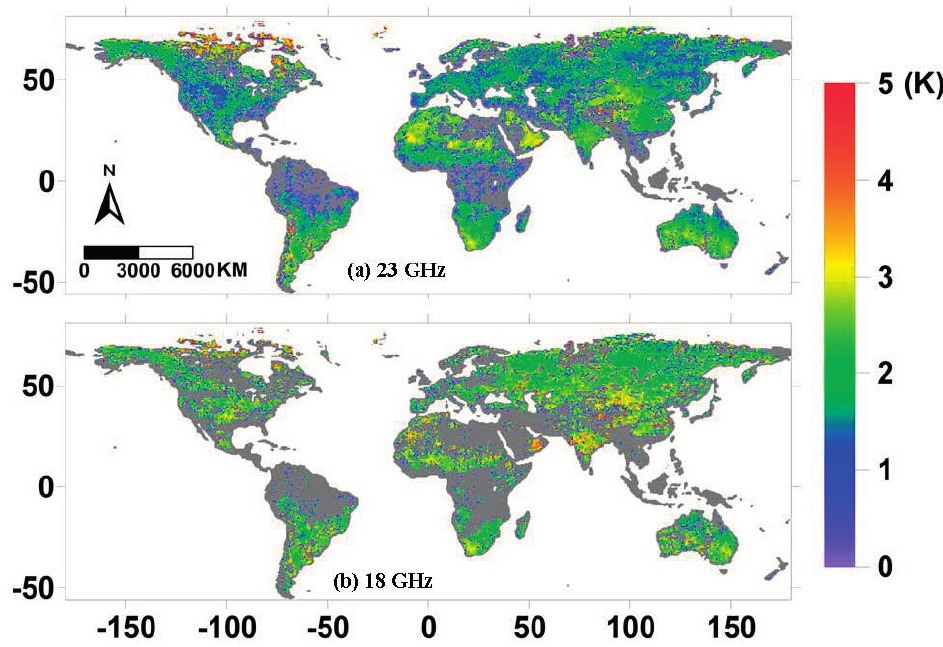
Figure 3. Example global distributions of estimated ascending orbit T uncalibrated AMSR2 and AMSR-E baseline observations for the H-Polarized ( a ) 23 GHz, and ( b ) 18 GHz channels, respectively (areas with correlation coefficient R < 0.95 are marked in